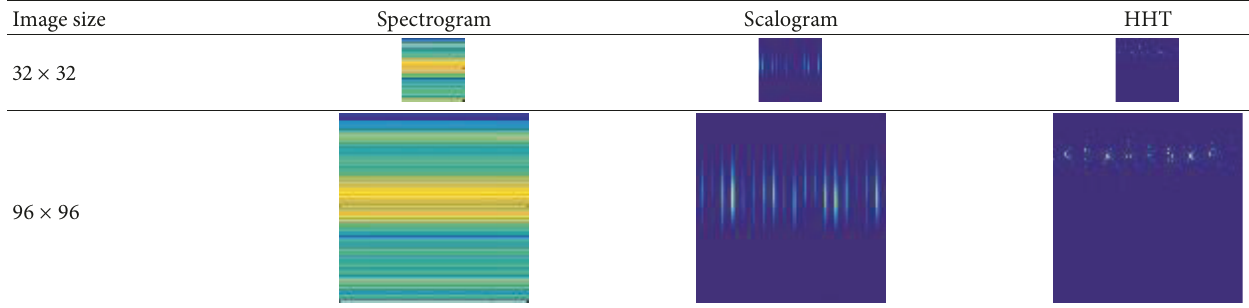
Table 17: CWR outer race images.